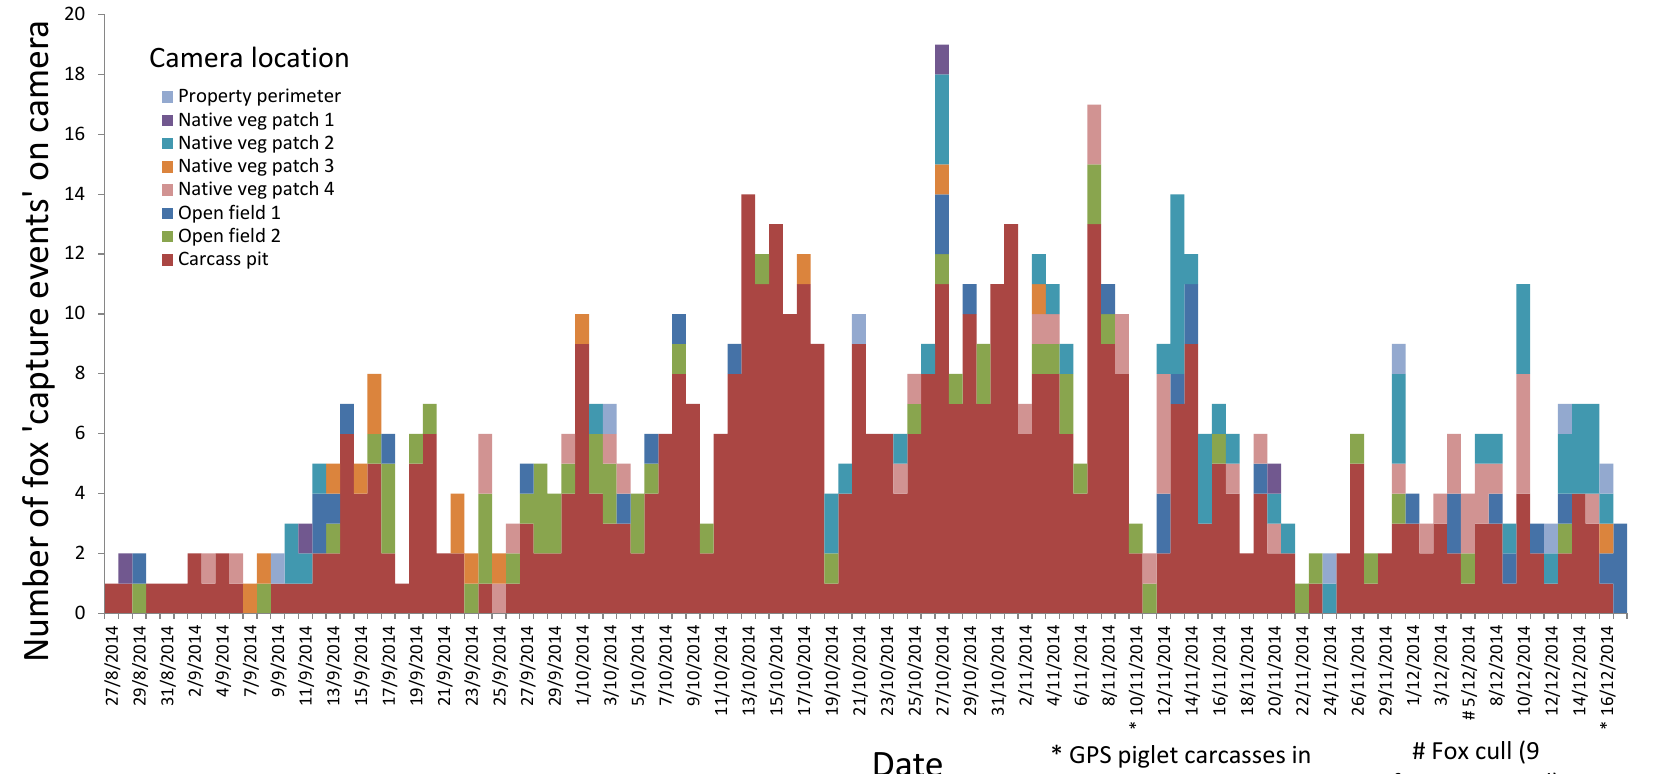
Figure 1. Fox activity at cameras placed in eight monitoring sites around the pork operation over 112 consecutive days (August–December 2014). Each fox capture event represents an individual fox seen on camera, with a minimum interval of 15 minutes between capture events.